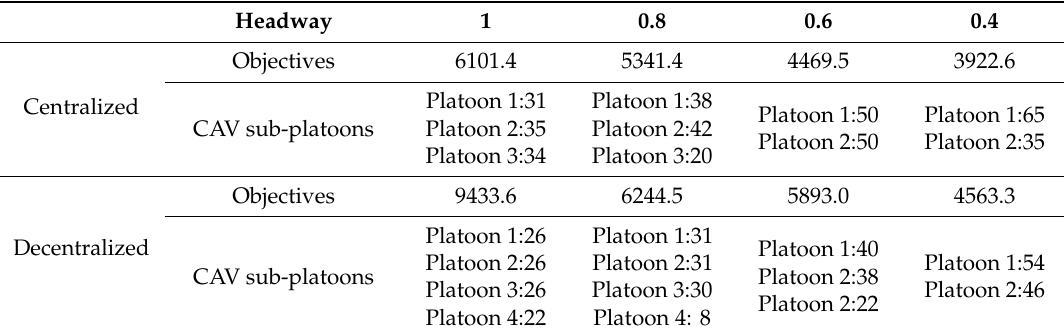
Table 5. Objective function value and CAV platoon splits for the proposed control algorithm under different initial following headways.